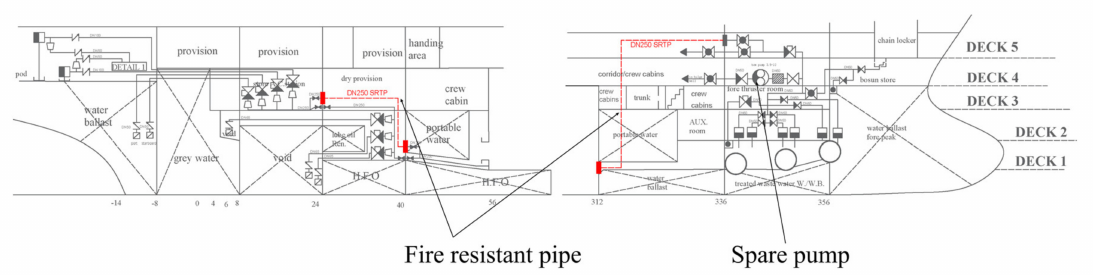
Figure 9. Bow- and stern-view of the rule bilge